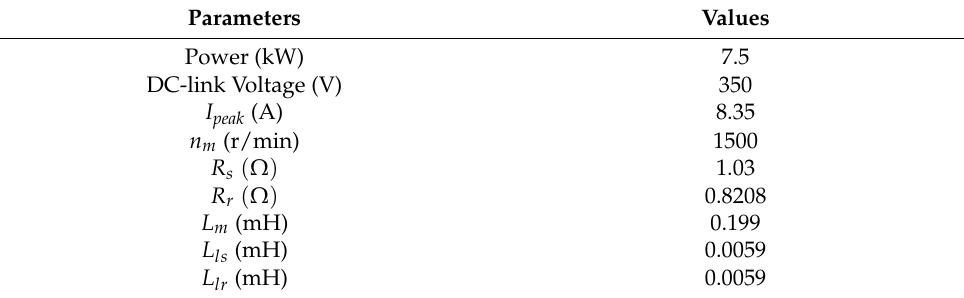
Table 1. Asymmetrical six-phase induction motor